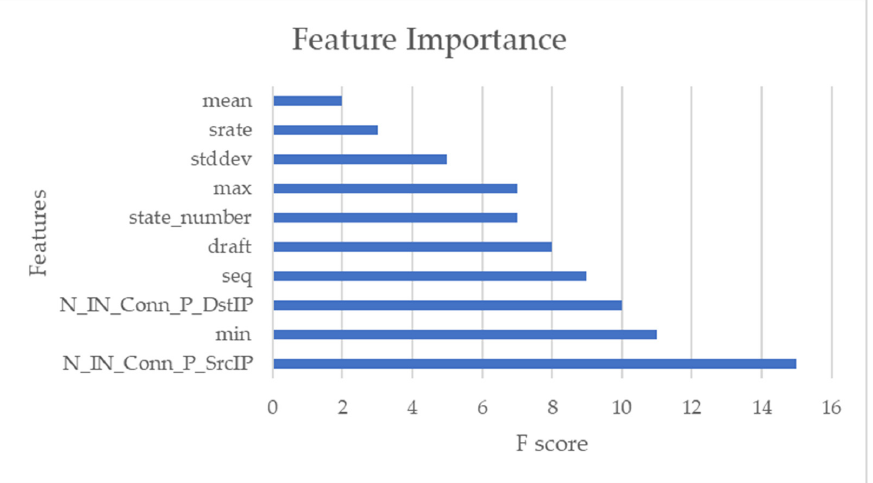
Figure 4. The feature importance score.